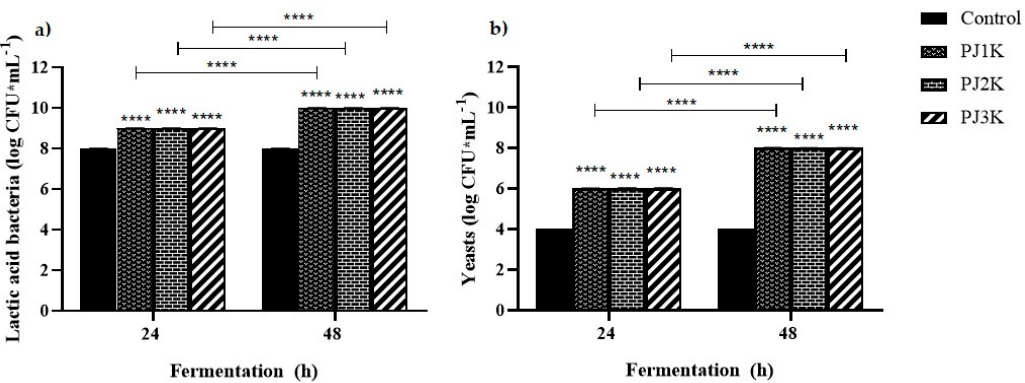
Figure 5. Cell counts of lactic acid bacteria ( a ) and yeasts ( b ) populations in kefir samples supplemented with (or without, used as control) 0.25 mg·mL − 1 of PJ1 (PJ1K), PJ2 (PJ2K), and PJ3 (PJ3K) during fermentation. Values represent the means of three independent experiments (each done in duplicate) ± standard deviation. Asterisks on the bars indicate that mean values were statistically different from the control, while asterisks on the dashes indicate differences among the same treatment at different time points (**** p < 0.0001).